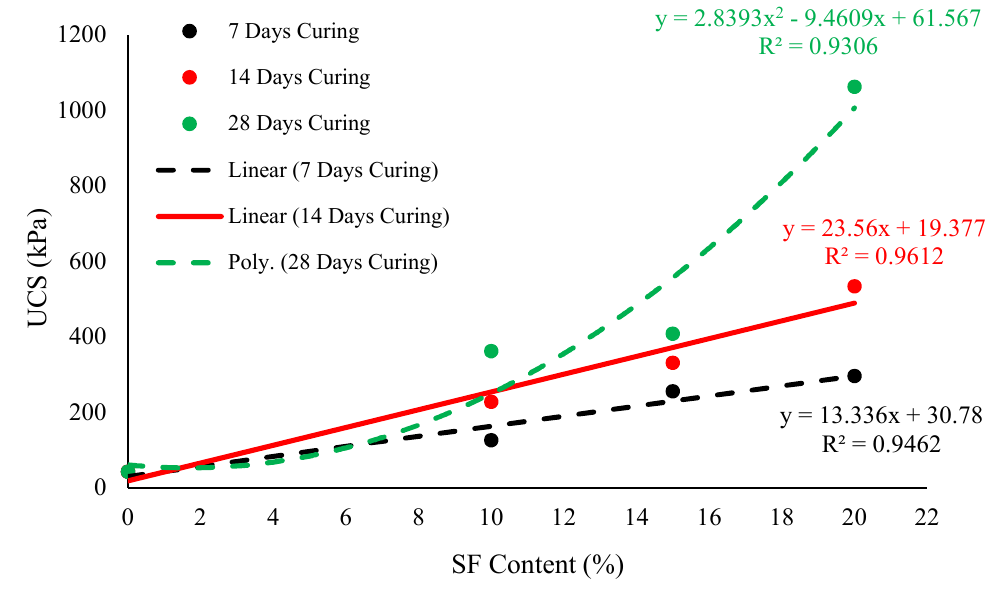
Figure 14. The statistical relationship between the increasing amounts of SF and UCS obtained after 7, 14, and 28 days of curing.